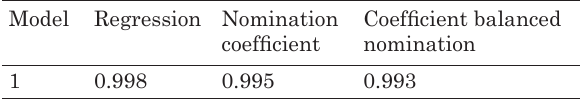
Table 6. Regression analysis and model nomination